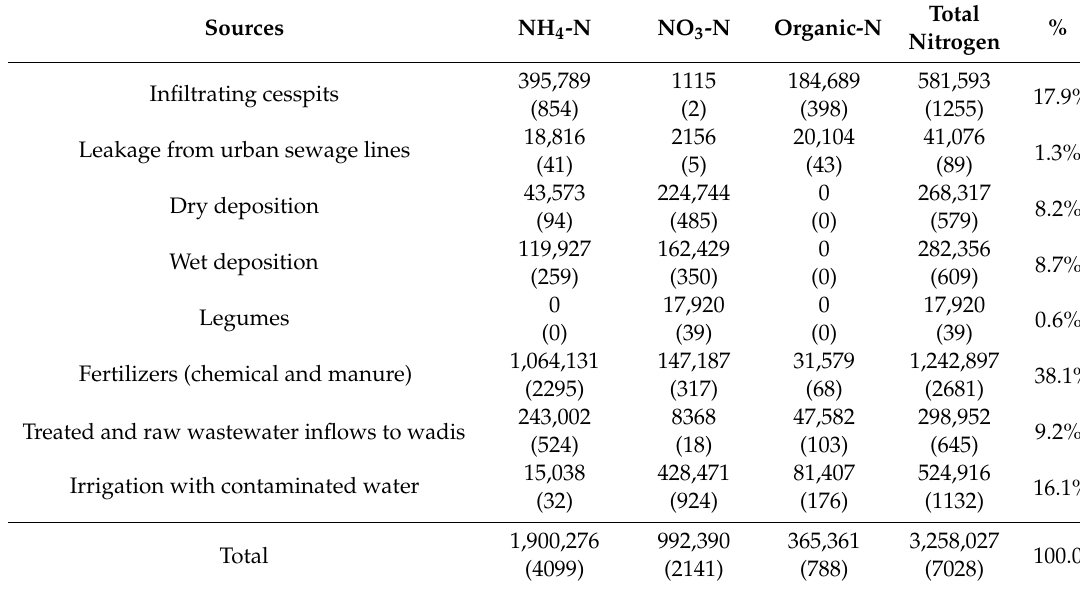
Table 4. Annual nitrogen amounts (kg) from the di ff erent sources in the area of the Eocene aquifer. The numbers between parentheses are in the units of kg-N / km